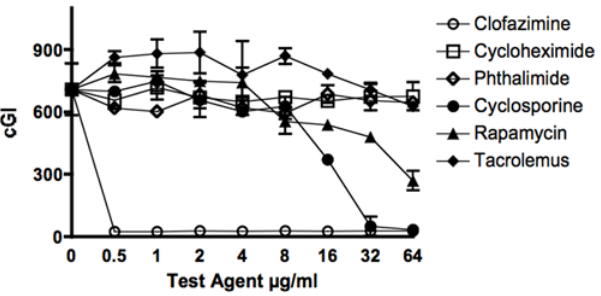
Figure 1. Shown are the inhibition data for a study employing MAP Dominic. The agents evaluated are Cyclosporine, Rapamycin and Tacrolimus. Of these three agents, the most pronounced inhibition is observed with Cyclosporine (see also Table 4.) Error bars are 6 SD. cGI=cumulative Growth Index (Bactec H ) The GI was 240 at the time of passage.